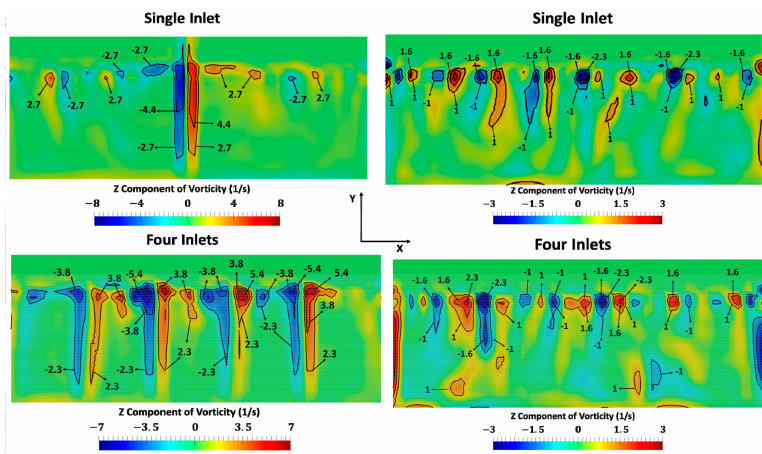
Figure 7. The component of the vorticity in the z direction on two xy planes: one at the centre of the tank, i.e., Z = 0.455 m ( left column) and one at the back of the tank, i.e., Z = 0.05 m ( right column), for the cases with one and four inlets. Contour lines for a selected number of vorticity values are shown on the plots.